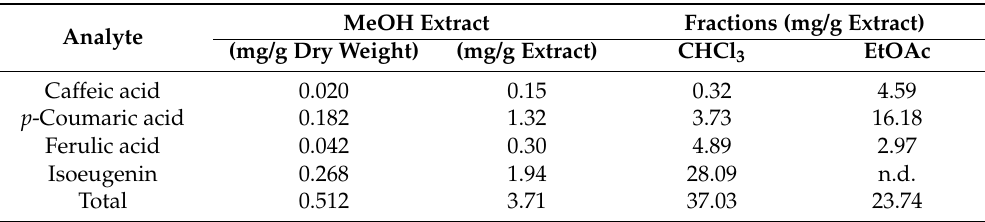
Table 2. Content of analytes in the extract and fractions of I. cylidrica .